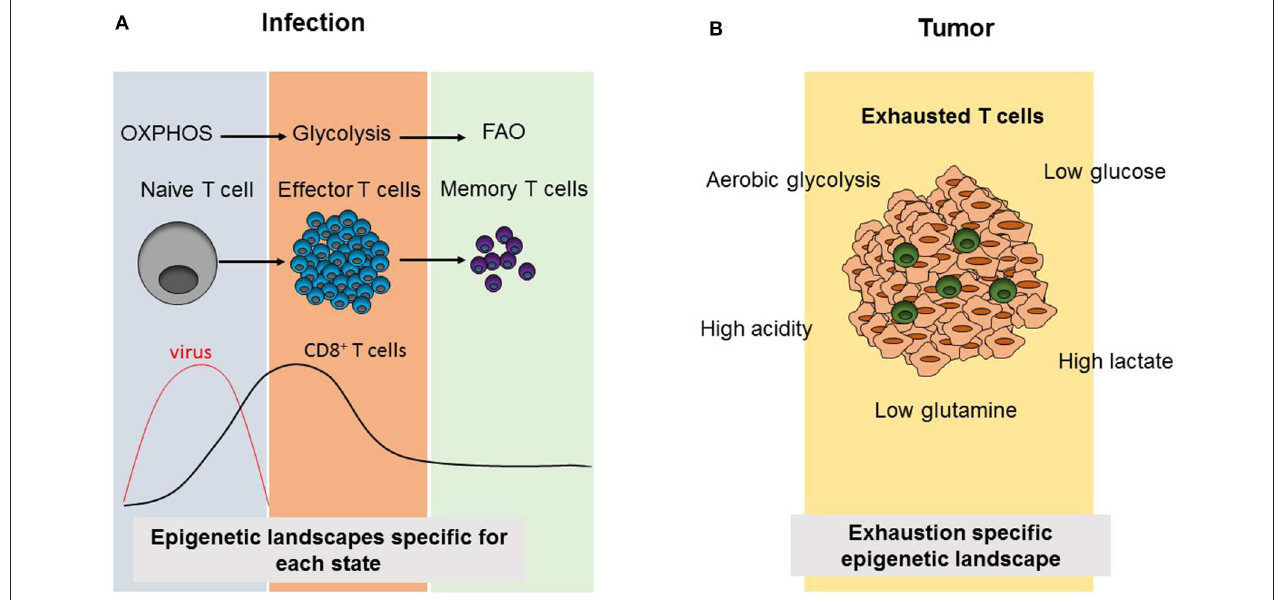
FIGURE 2 | Comparison of CD8 + T cell differentiation and metabolism as well as epigenetic landscapes during infection and tumorigenesis. (A) Virus infection results in the activation of naïve CD8 + T cells triggering the differentiation into effector cells, which induce viral clearance. Subsequently, effector T cells contract and leave behind a small population of memory CD8 + T cells. During this differentiation process, CD8 + T cell subsets use the indicated cellular metabolism pathways and acquire different epigenetic landscapes specific to each phase. (B) In tumors, the presence of immunosupressive environments due to metabolic alterations in tumor cells results in an exhausted phenotype, in which tumor infiltrating T cells are not able to compete with tumor cells for metabolic products and they become non-functional resulting in increasing tumor growth. Exhausted T cells also acquire an exhaustion-specific epigenetic